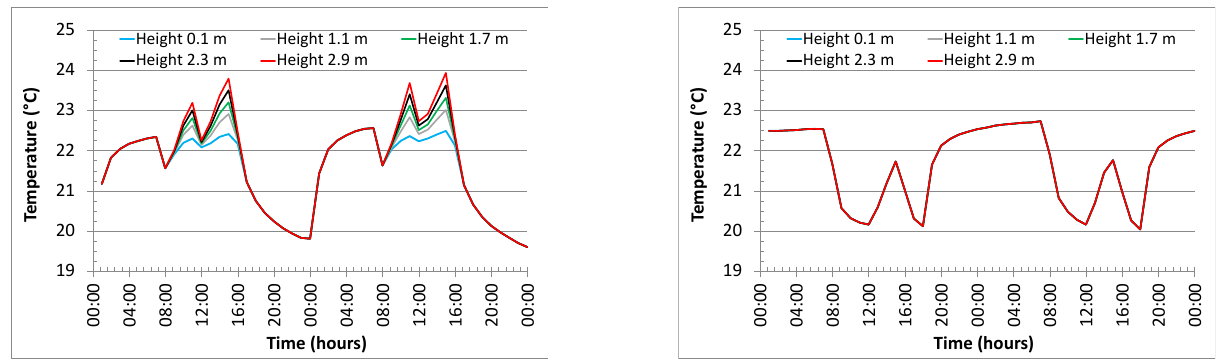
Figure 19. Simulated vertical temperature profiles for Scenario I ( left ) and Scenario II ( right ) of the lab test.